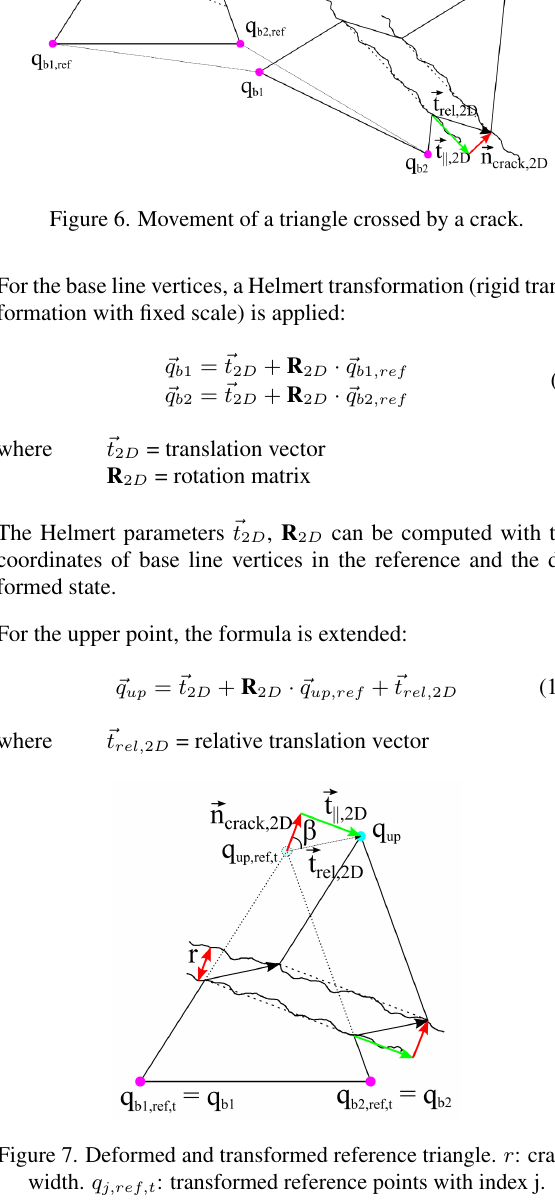
ment field. The threshold should be in the order of